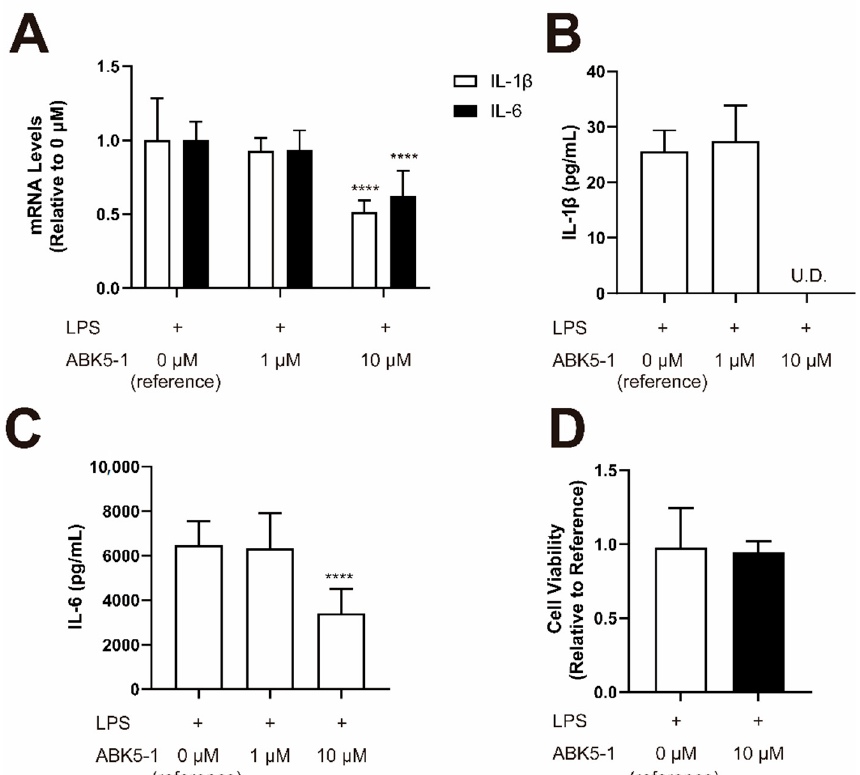
Figure 6. Effect of ABK5-1 on lipopolysaccharide (LPS)-induced cytokine production in microglia. BV-2 cells were pretreated with DMSO (<0.1%) or 1 or 10 µ M ABK5-1 and stimulated with LPS. ( A ) mRNA levels of IL-1 β and IL-6 after 6 h of LPS stimulation. ( B ) IL-1 β protein concentration in the cell culture medium after 24 h of LPS stimulation. U.D. indicates under detection limit. ( C ) IL-6 protein concentration in the cell culture medium after 24 h of LPS stimulation. ( D ) Viability of BV-2 cells after ABK5-1 10 µ M treatment. Results are indicated as the mean ± S.D. of three independent assays performed for each concentration. One-way ANOVA plus Dunnett’s post-hoc test were used and **** p < 0.0001 (versus reference).